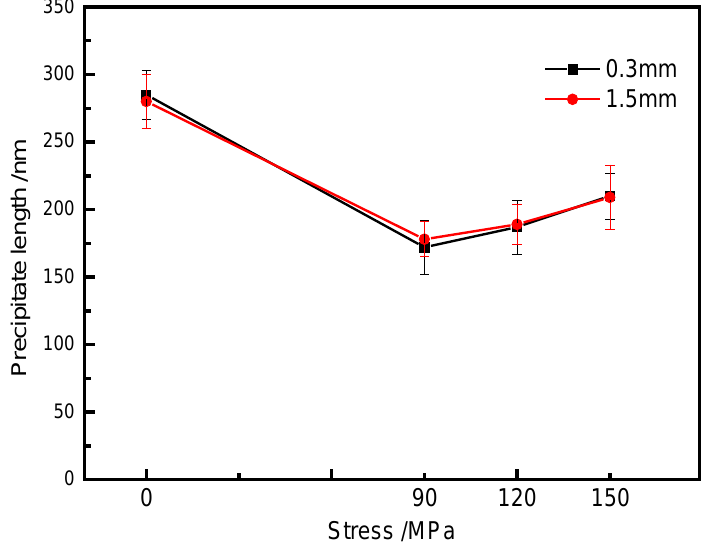
Figure 9. The precipitates length of AA2024 after different creep ages.